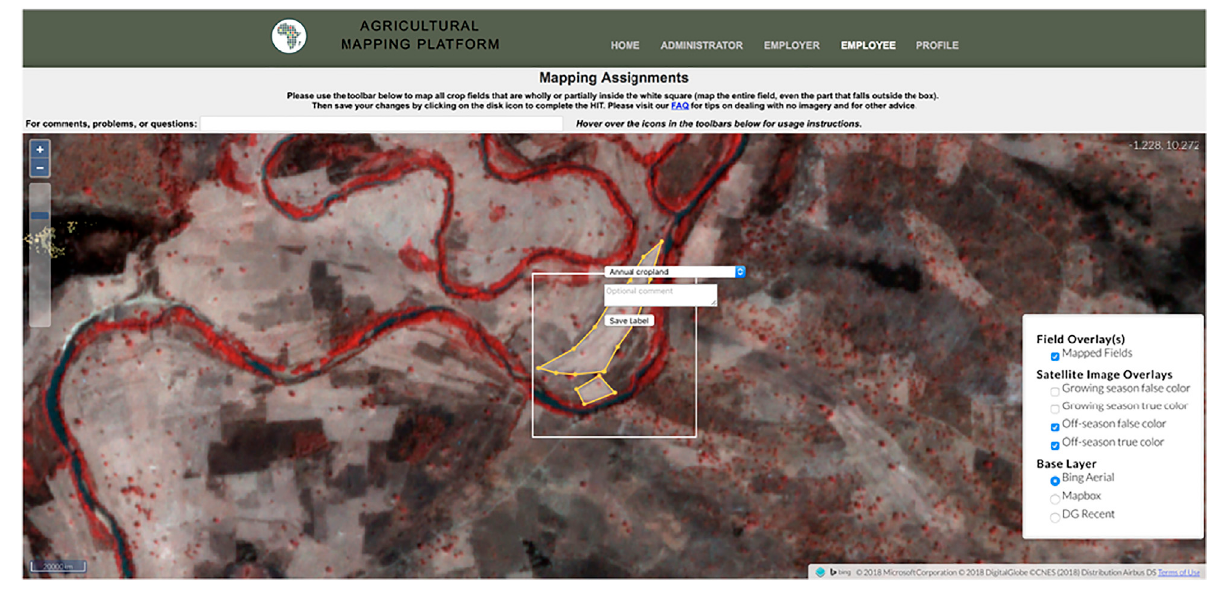
FIGURE 2 | An overview of the labelling platform ’ s